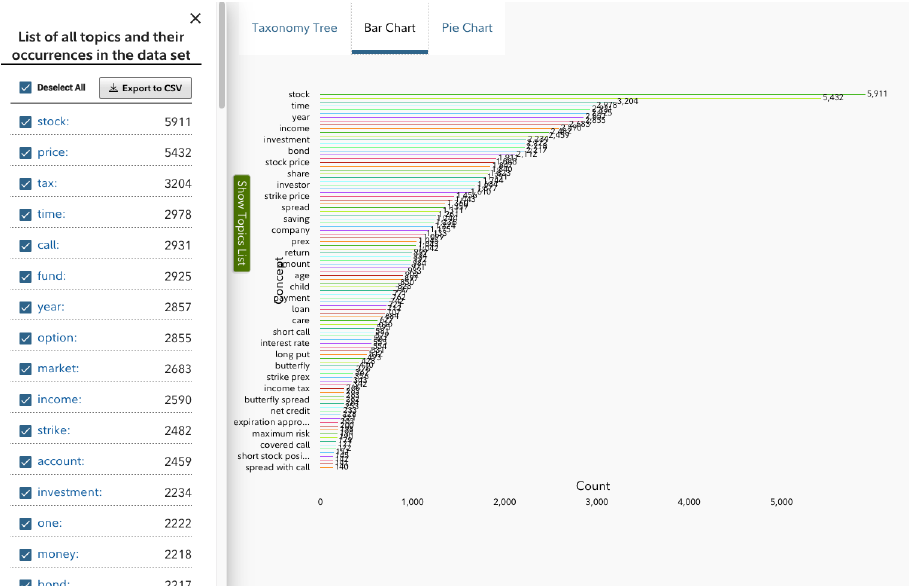
Figure 3. A screenshot of the Conversation Concepts Artificial Intelligence (CCAI) tool, showing the topics extracted from the financial articles (LC). LC documents cover a range of financial education topics and are publicly available. The key terms are ordered by the frequency of their occurrence within the corpus.